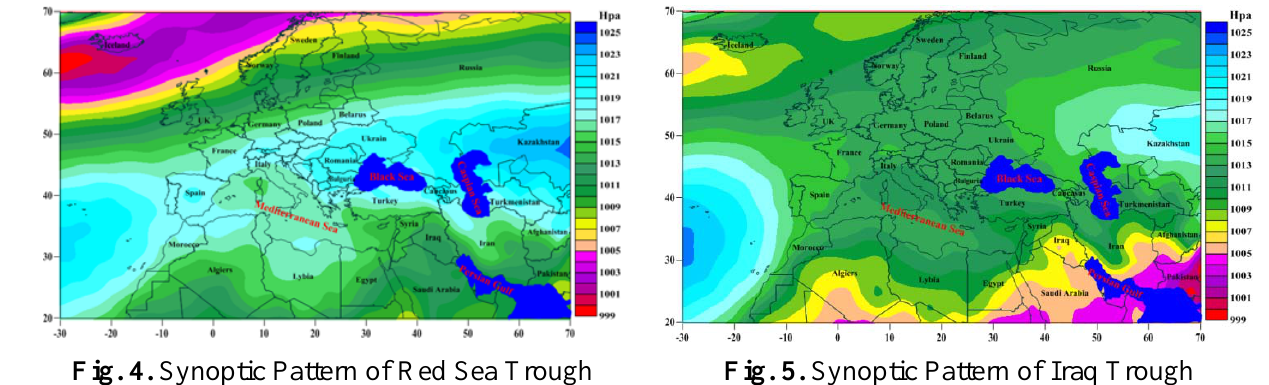
Fig. 4. Synoptic Pattern of Red Sea Trough Fig. 5. Synoptic Pattern of Iraq